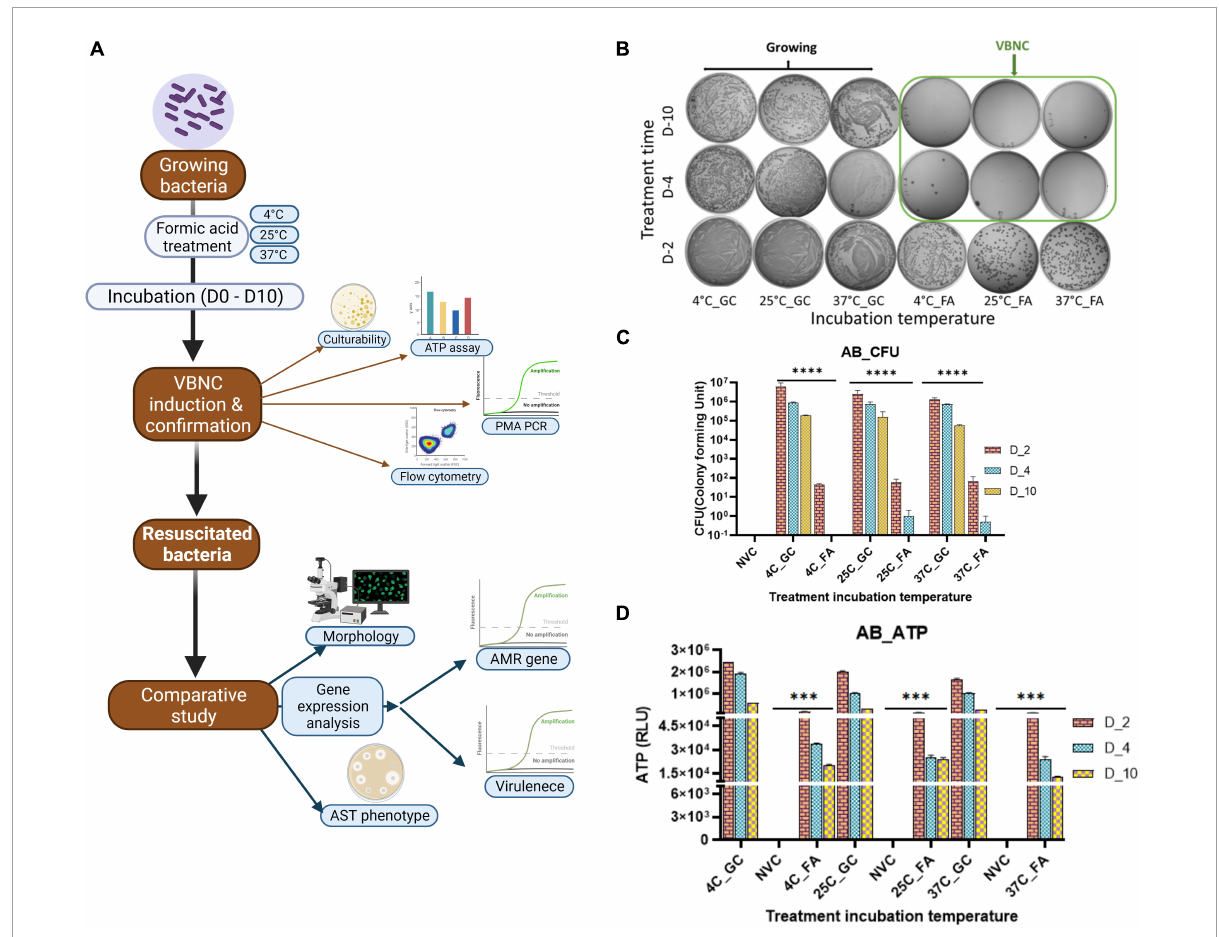
FIGURE1 Viable-but-non-culturable (VBNC) optimization VBNC induction after formic acid (FA) treatment was checked on day 2, day 4, and day 10. VBNC induction was confirmed by using two properties of the VBNC state, non-culturability and metabolic energy production, in Acinetobacter baumannii ( Klebsiella pneumoniae and E. coli refer Supplementary Figure 1 ) with FA treatment at three different incubation temperatures, that is, 4, 25, and 37 ◦ C. The study work flow representation (A) VBNC induction optimization in A. baumannii culturability assessment, (B) quantitative representation of culturability (C) , and ATP production (D) . All three study isolates show growth on day 2 but the loss of culturability on day 4–day 10 (B) . This reduction of growth in VBNC was highly significant when compared to untreated growing bacteria from the same incubation temperature while non-significant in non-viable bacteria (C) . Non-growing bacteria on day 4–day 10 showed significant ATP production when compared to non-viable bacteria in all three study isolates (D) . FA, formic acid; GC, growing control; NVC, non-viable